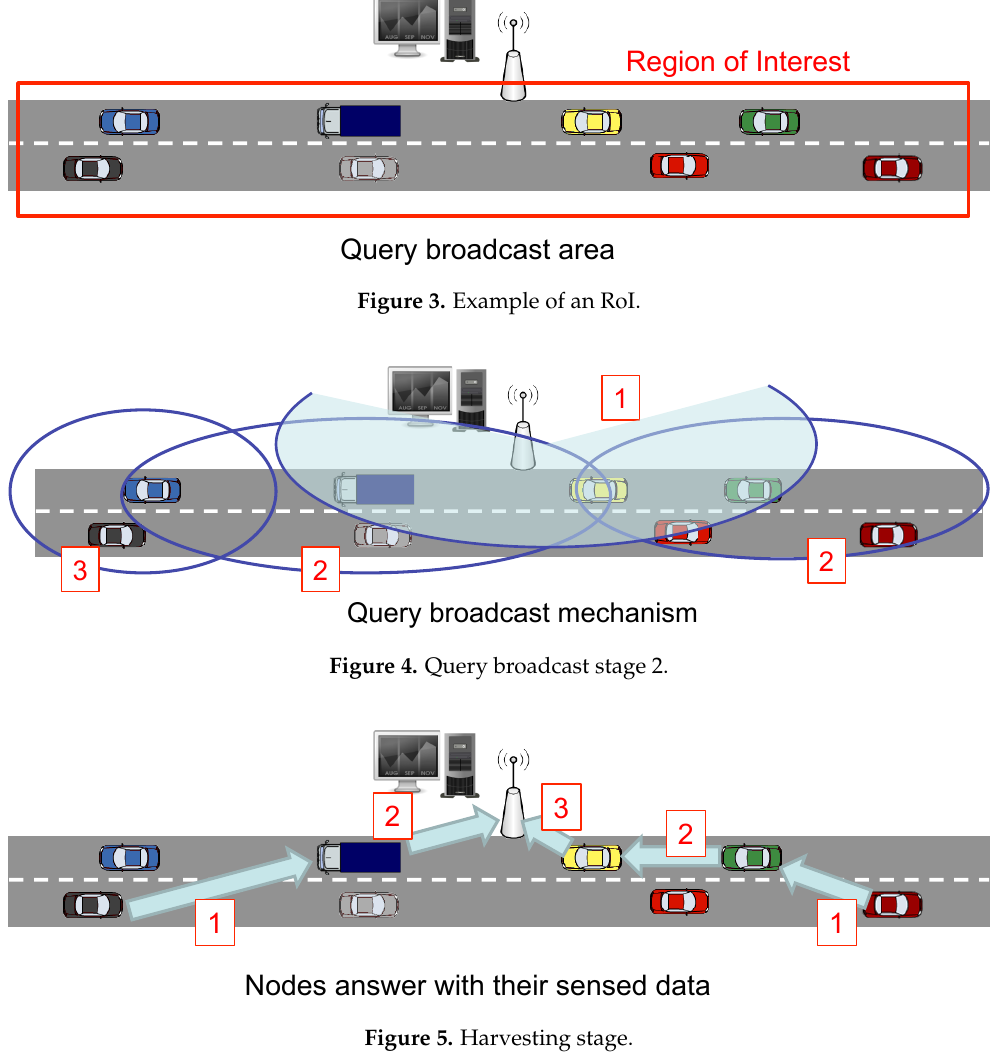
Figure 5. Harvesting